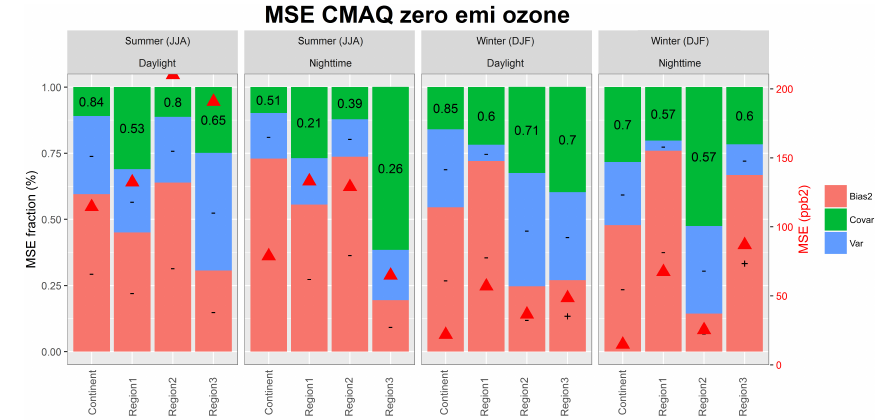
Figure 8. As in Fig. 6 for the hourly time series of “zeroed anthropogenic emissions” scenario.